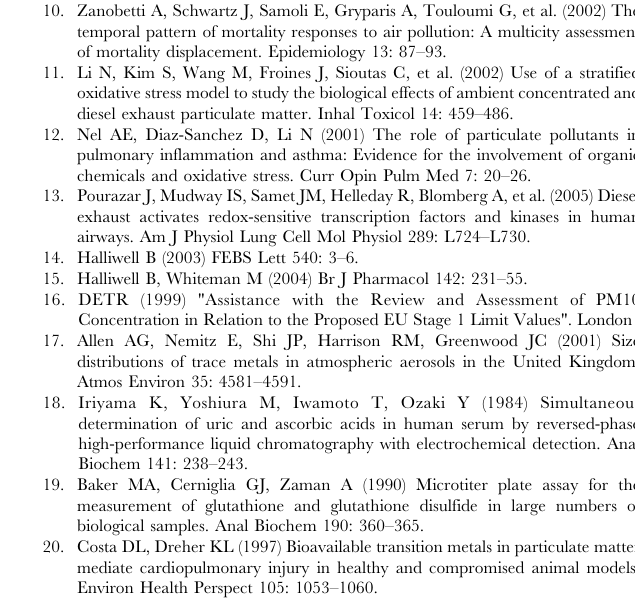
Figure S1 Mean size-fractionated PM trace metal (Fe, Cu, Ba, Al) concentrations at primary school sampling sites. Each bar represents the mean of two filter samples per site visit with the associated standard deviation. Diamond markers indicate the mean total PM 10.2 trace metal concentration for each site. (TIF)